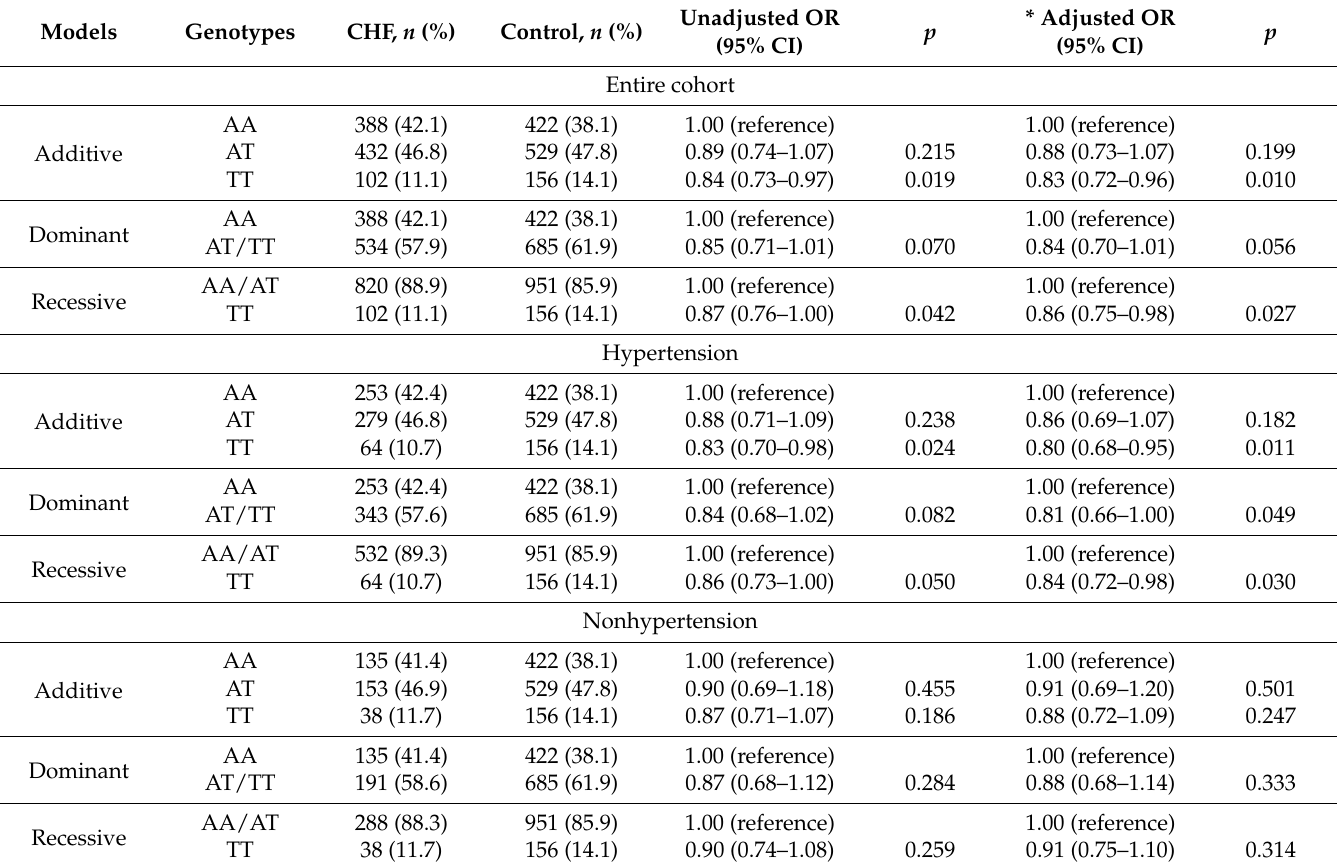
Table 2. Association of BSG rs8259 polymorphism with risk of